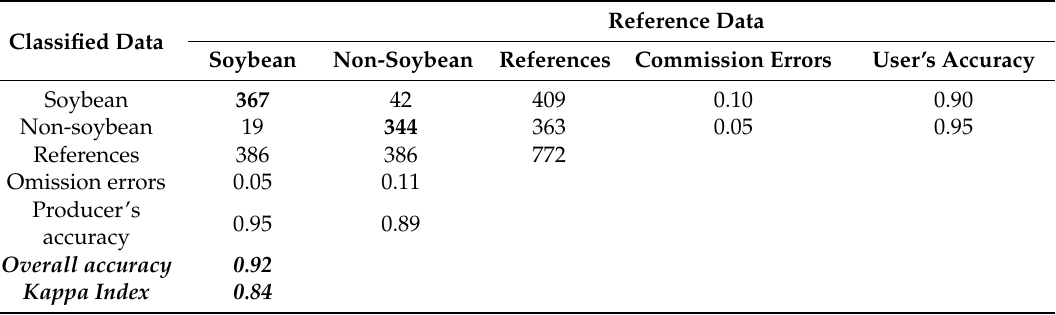
Table 2. Error matrix with SEI Pixel and in situ checkpoint data, and mapping accuracy for the 2010/2011 crop